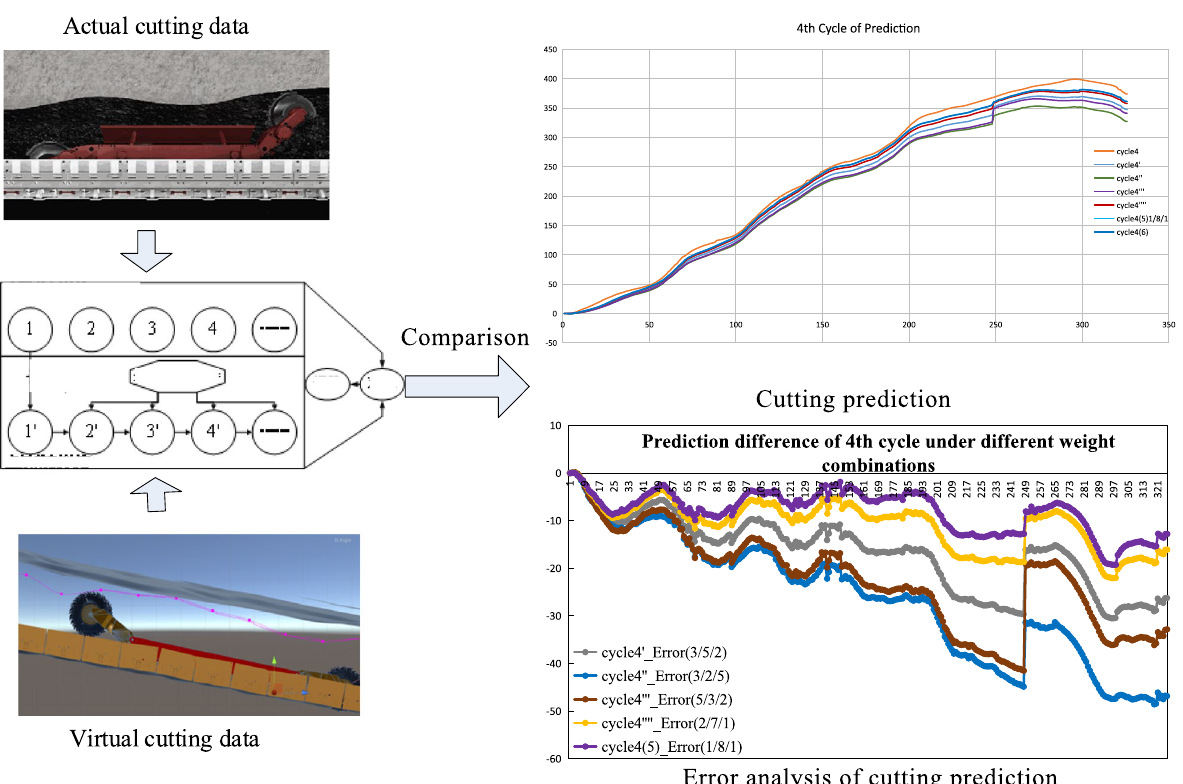
Fig. 12 Forecast coal seam conditions